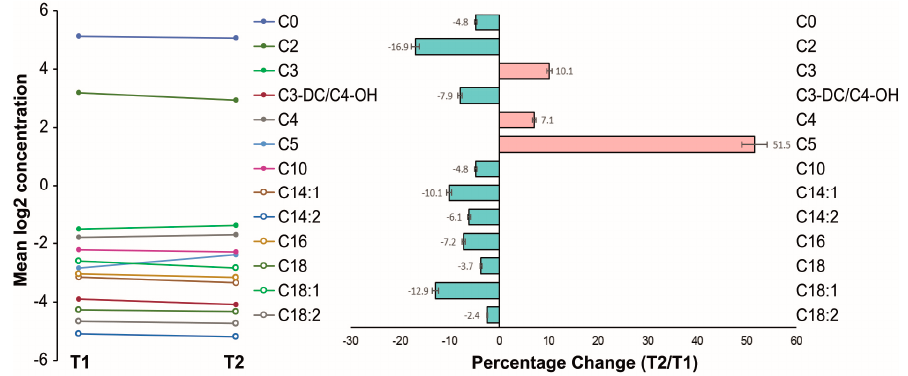
Figure 2. Changes of acylcarnitines before and after left atrial appendage closure over mid-term follow-up. ( Left ) Mean logarithmic changes of carnitine and acylcarnitine plasma levels for each analyzed metabolite; ( right ) percentage change. Table 3. Metabolite concentrations, standard deviations, and percentage change.